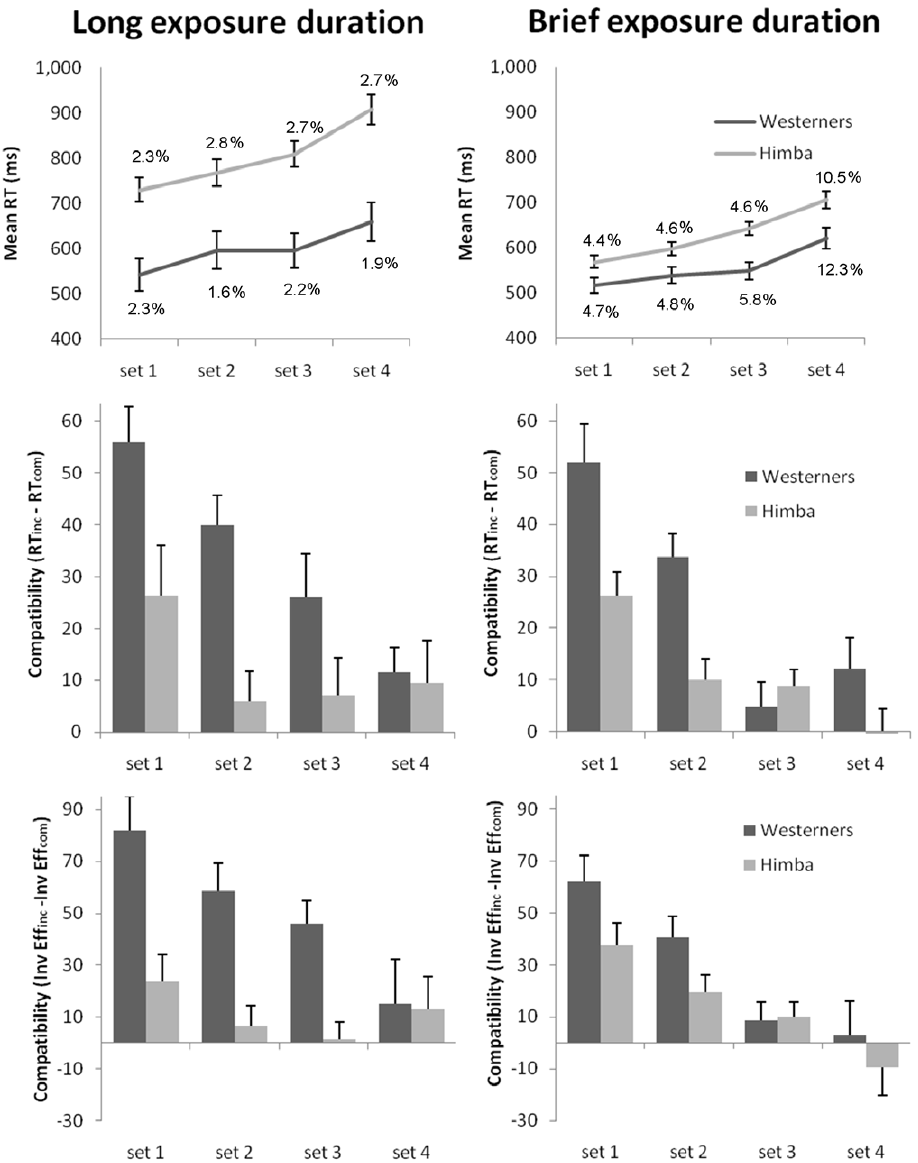
Figure 2. Results for Experiment 1. Left panels present the data from the long exposure duration condition, right panels present the data from the brief exposure duration condition. (A) Overall mean reaction time and error rate for Westerners and Himba as a function of set size and exposure duration. Error bars represent standard error. Percentage values are overall error rates. (B) Mean distractor compatibility effects (reaction time) for Westerners and Himba as a function of set size and exposure duration. *, p , .05; **, p , .01; ***, p , .001. Error bars represent standard error. (C) Mean distractor compatibility effects (inverse efficiency scores) for Westerners and Himba as a function of set size and exposure duration. *, p , .05; **, p , .01; ***, p , .001. Error bars represent standard